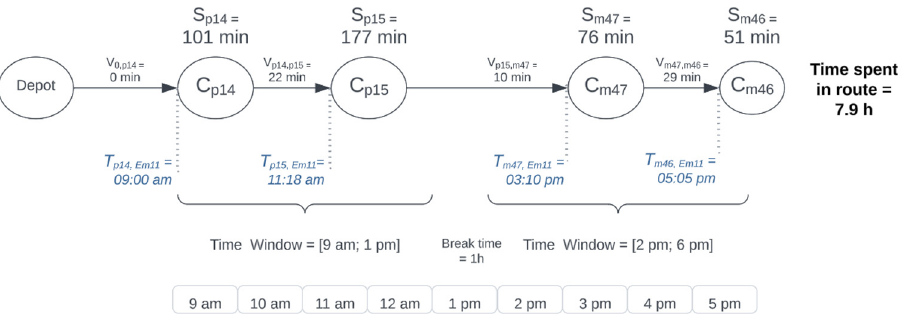
Figure 3. Route planning for the team E m11 .